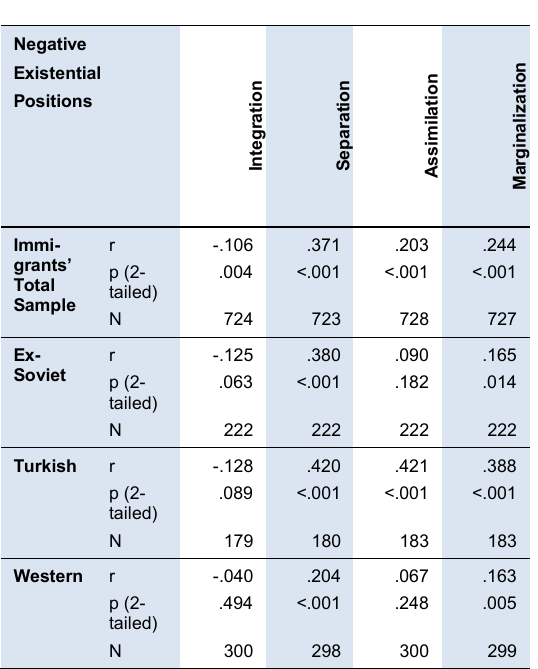
Table 5: Correlations among the Styles of Acculturation and the Negative Existential Position 3 Style of